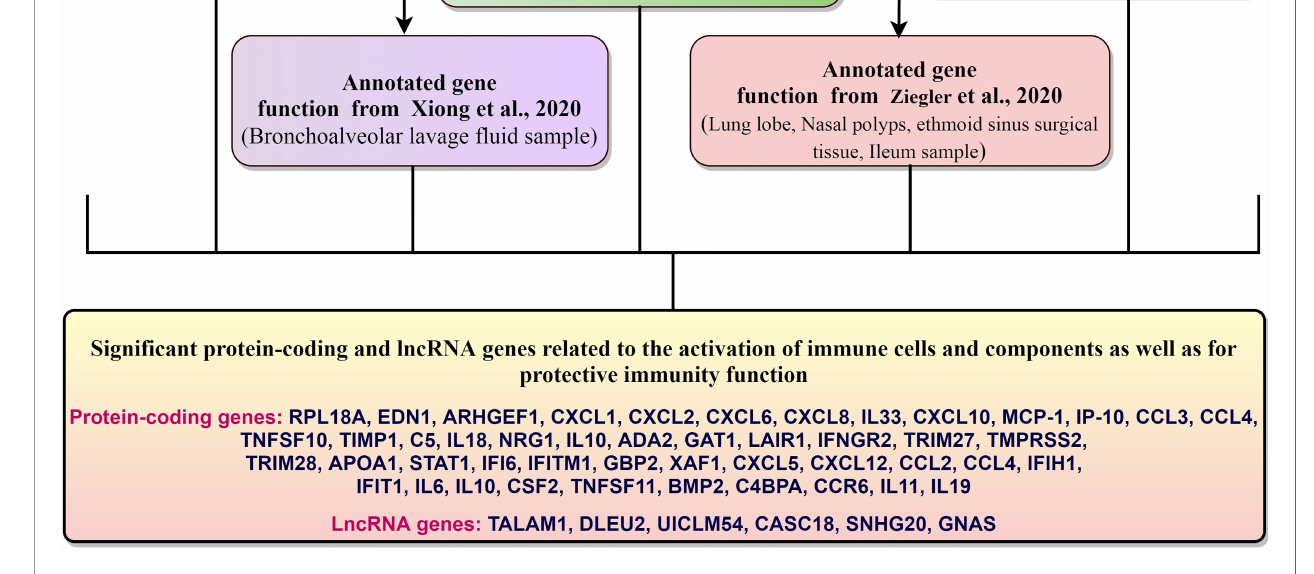
FIGURE 12 | The genes associated with the immune response elements and protective immunity from